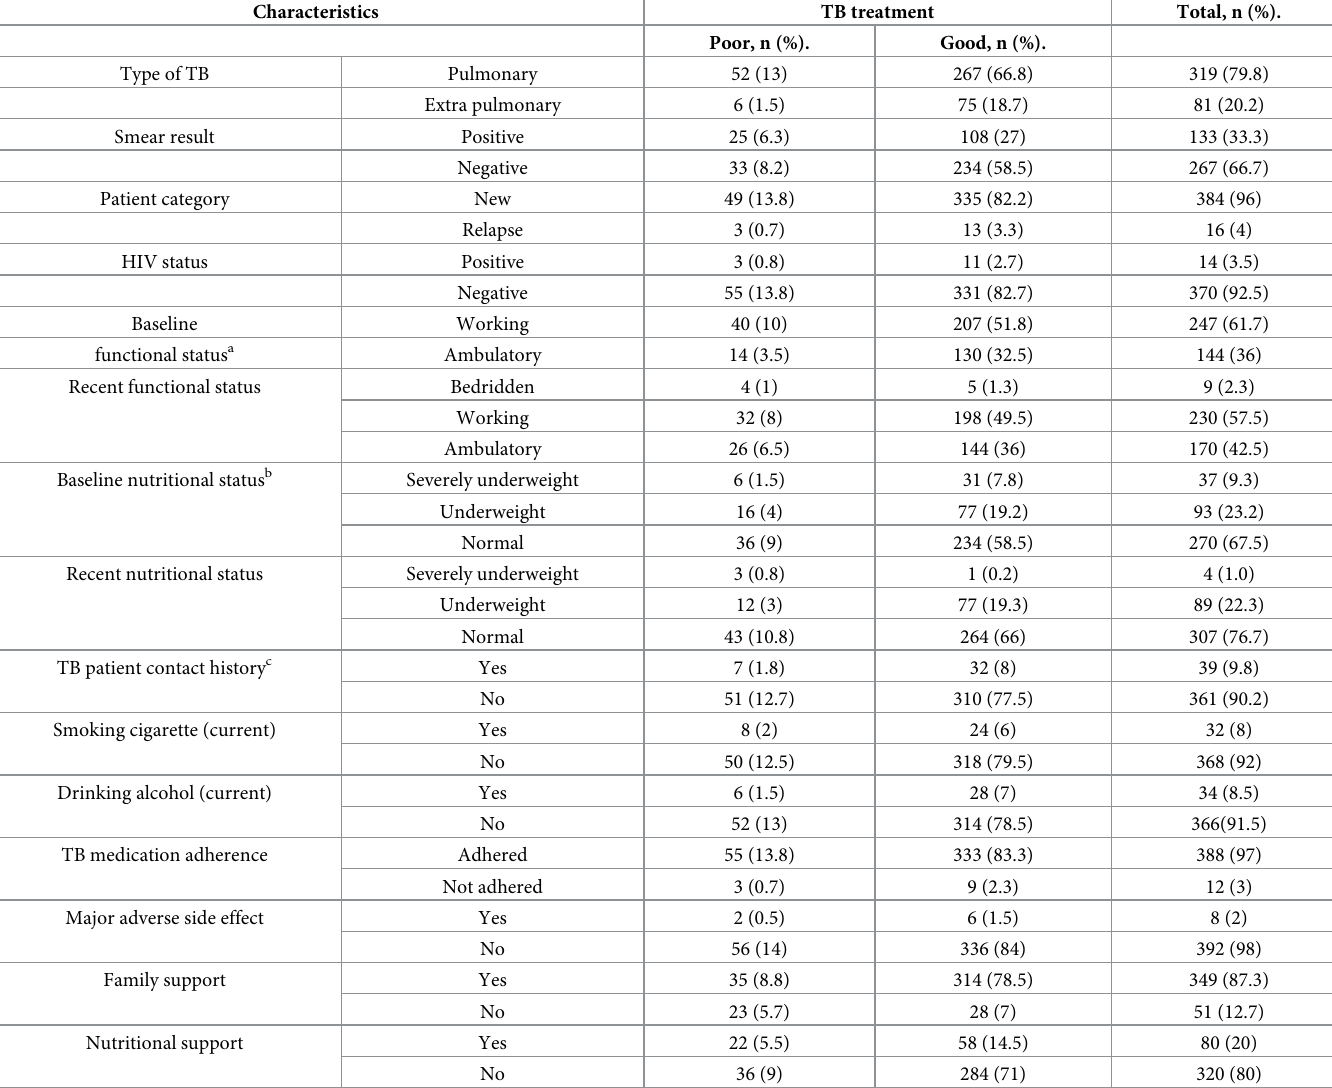
Table 2. Clinical and behavioural characteristics among adult patients registered at Gibe Woreda public health facilities, Hadiya zone, Southern Ethiopia from 1 st January 2017 to 31 st December 2019. Characteristics TB treatment Total, n